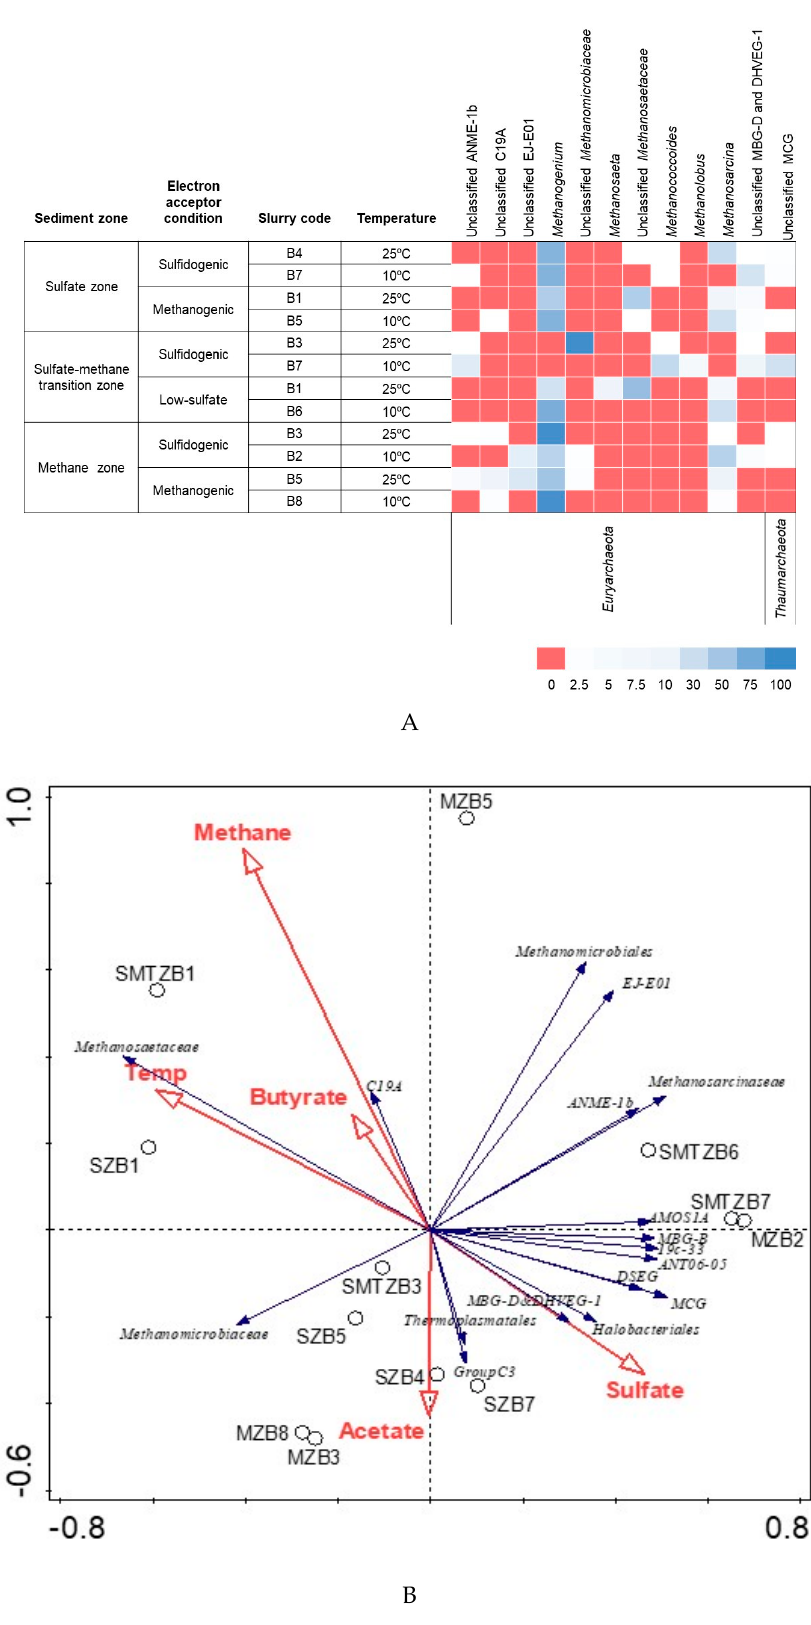
Figure 5. ( A ) The heatmap depicts the relative abundance of the most common ( > 5 %) archaeal 16S rRNA gene sequences (unless unclassified) across the 12 slurries analyzed. The heatmap colors